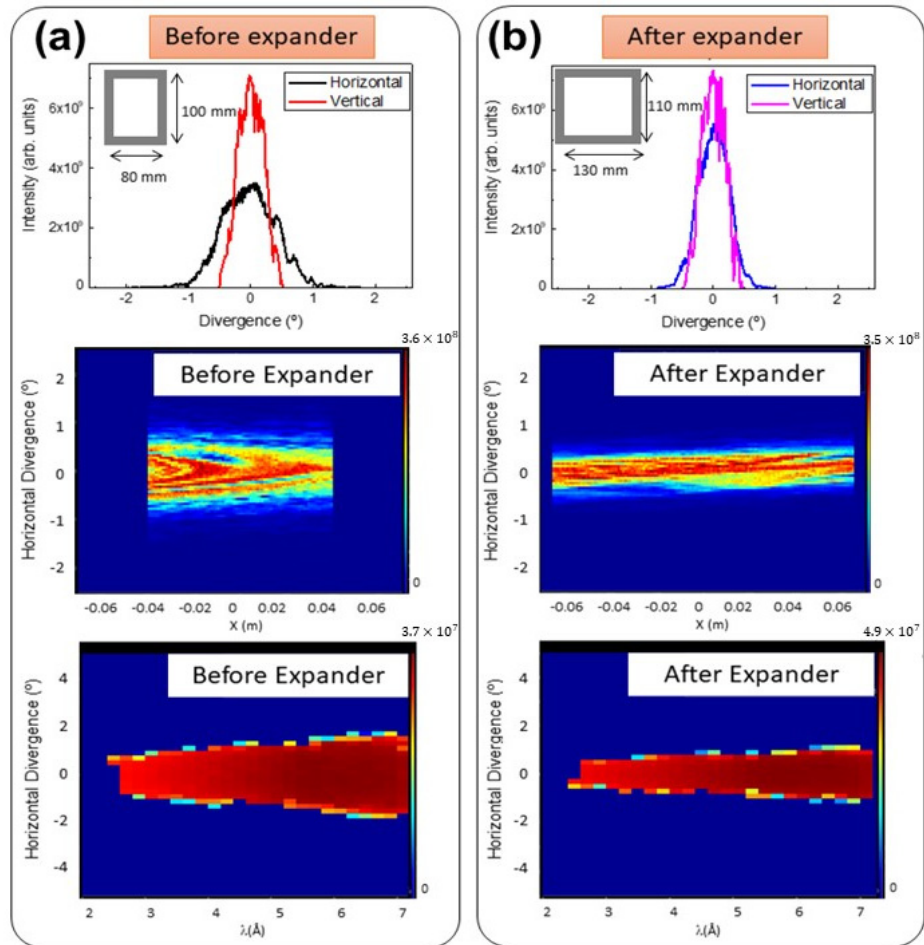
Figure 6. Overall divergence distribution ( top ) and acceptance diagrams with the horizontal divergence distribution as a function of position ( middle ) and wavelength ( bottom ), ( a ) before the expander and ( b ) after the expander. The grey rectangle represents the guide section at every position.